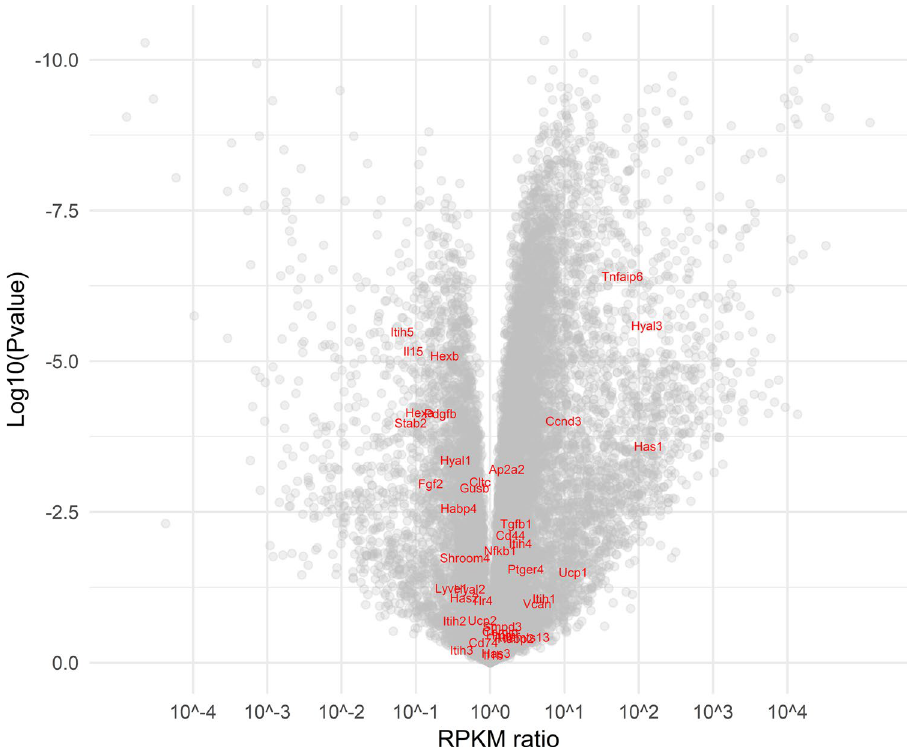
Figure 8. HA-family gene expression in NMR vs mouse lymph nodes. Volcano plot of HA-family genes, spotted in red on grey background of all other genes. The p-value for differential gene expression between the two species is plotted vs gene expression fold-change.